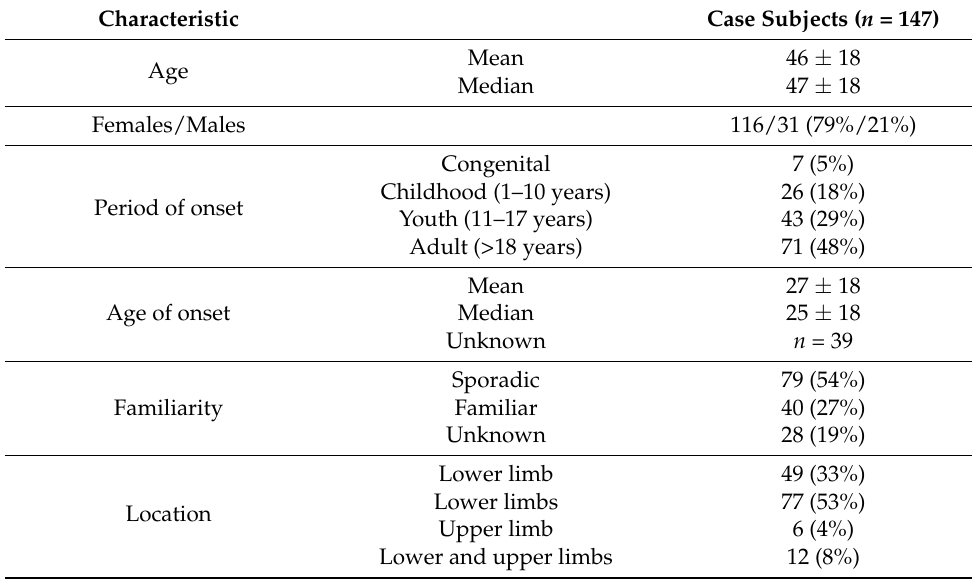
Table 1. Characteristics of the probands analyzed for this